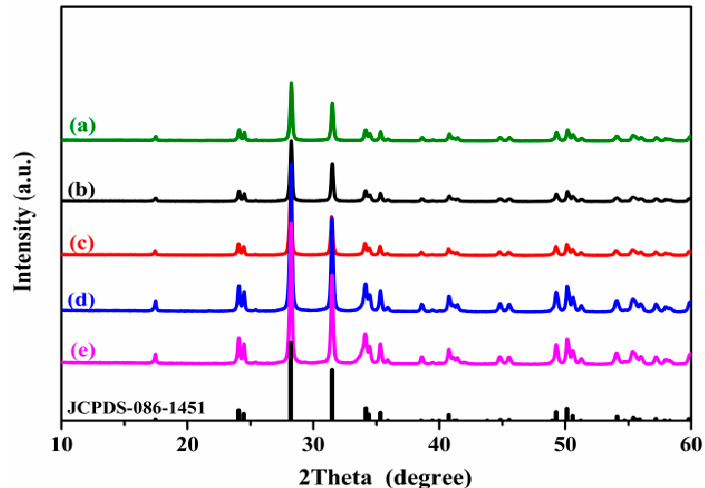
Figure 1. X-ray diffraction patterns of the support and catalysts: ( a ) m-ZrO 2 ; ( b ) 1% Pd/Z; ( c ) 1% Figure 1. X-ray di ff raction patterns of the support and catalysts: ( a ) m-ZrO 2 ; ( b ) 1% Pd / Z; ( c ) 1% PdAg/Z; ( d ) 2% PdAg/Z; ( e) 5% PdAg/Z. PdAg / Z; ( d ) 2% PdAg / Z; ( e ) 5% PdAg /